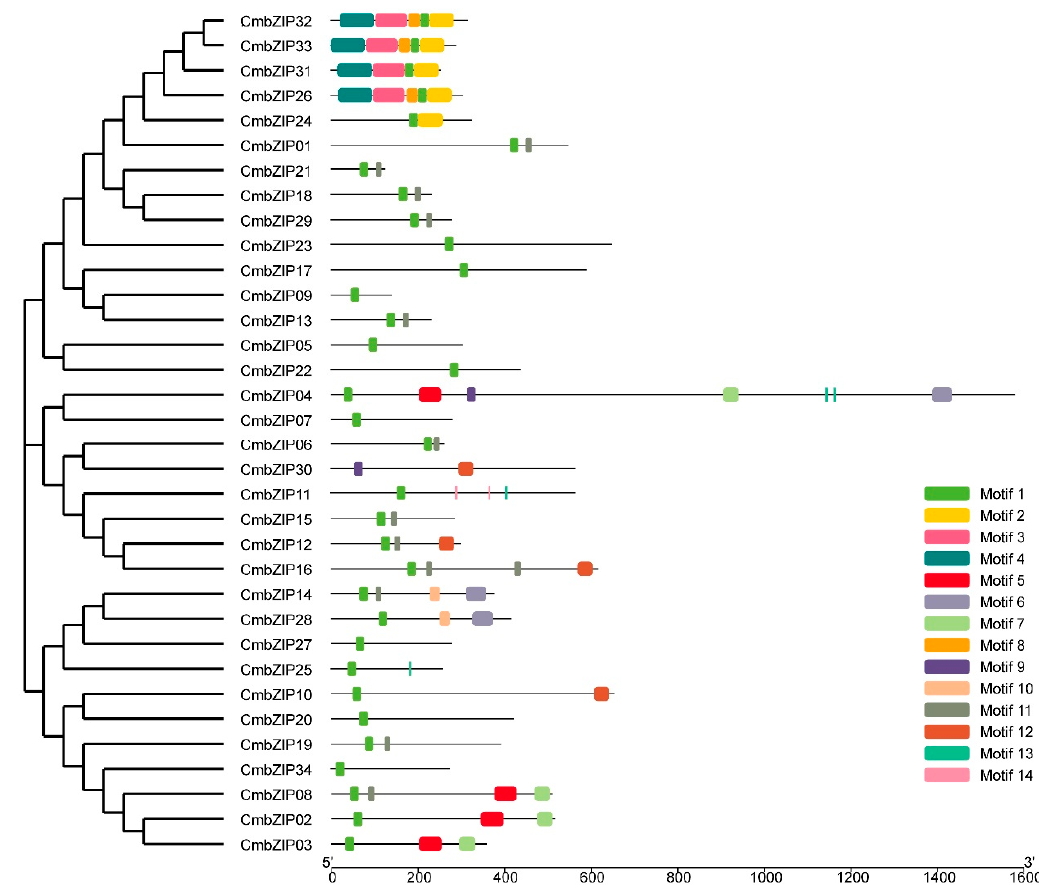
Figure 5. Distributions of conserved motifs in CmbZIP genes. MEME was used to recognize additional conserved motifs of bZIP transcription factors in C. minitans . Fourteen motifs are highlighted in different colored boxes. Multilevel consensus amino acid sequences of predicted conserved motifs are listed in Figure S2.